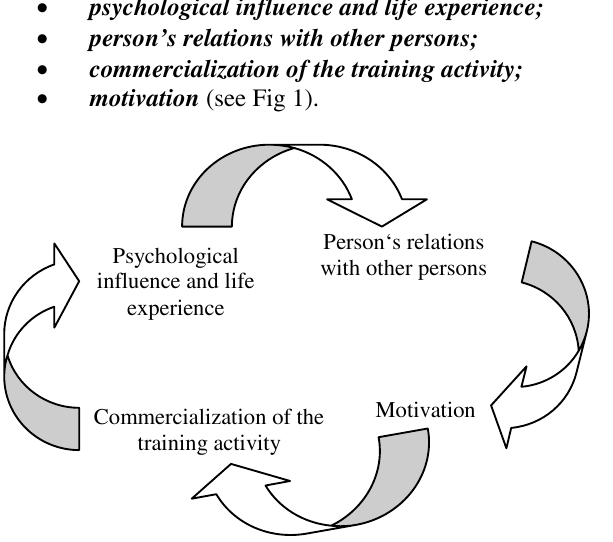
Fig 1. Model of problem fields in the training process